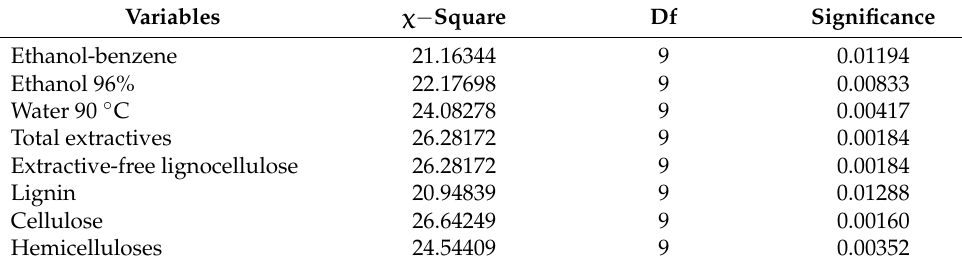
Table 2. Kruskal-Wallis analysis for the lignocellulosic and extractives variables.